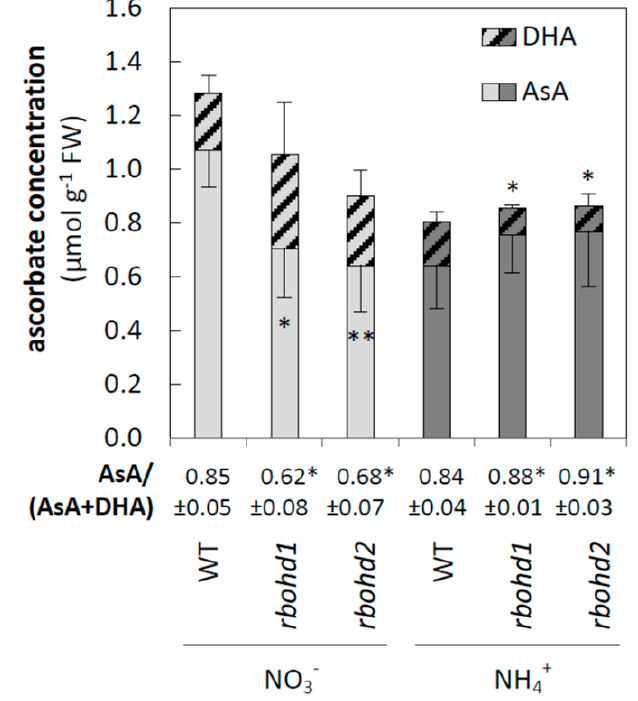
Figure 3. Ascorbate and dehydroascorbate concentration in leaves of WT and rbohd plants grown in medium containing nitrogen in the form of nitrate or ammonium ions. Comparison tests between rbohd and WT plants were performed on the mean experimental conditions for the nitrate (light grey) or ammonium (dark grey) growth regime separately. Statistical differences calculated using one-way analysis of variance (ANOVA) with Tukey’s post hoc test are indicated at p -value ≤ 0.01 ** and p -value ≤ 0.05 *. Rbohd mutants have tended to increase the level of oxidized glutathione in response to nitrate, but the GSH/(GSH + GSSG) ratio was significantly changed only in rbohd1 plants. However, similar to ascorbate, the glutathione pool was more reduced under ammonium nutrition in rbohd plants than in WT plants (Figure 4a). Since GR in the Arabidopsis genome is encoded by two isoforms with different intracellular localizations, the transcript levels of both genes were checked. No clear trend was observed for GR1, since the studied lines of transformants showed different regulations of this gene in response to nitrogen source; nitrate nutrition resulted in a lowered expression of GR1 in rbohd1 , whereas ammonium nutrition increased the expression of GR1 in the rbohd2 line. Simultaneously, the expression of GR2 , downregulated by ammonium in WT plants in both transformants, was further repressed under ammonium cultivation (Figure